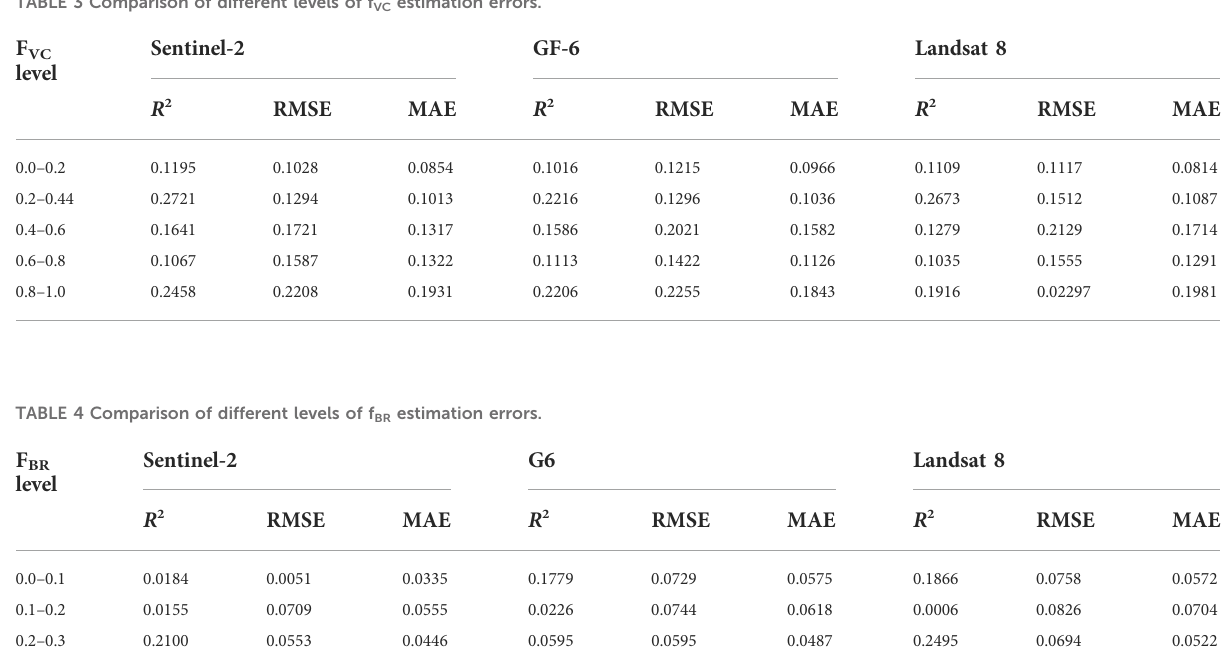
TABLE 3 Comparison of different levels of f VC estimation errors.